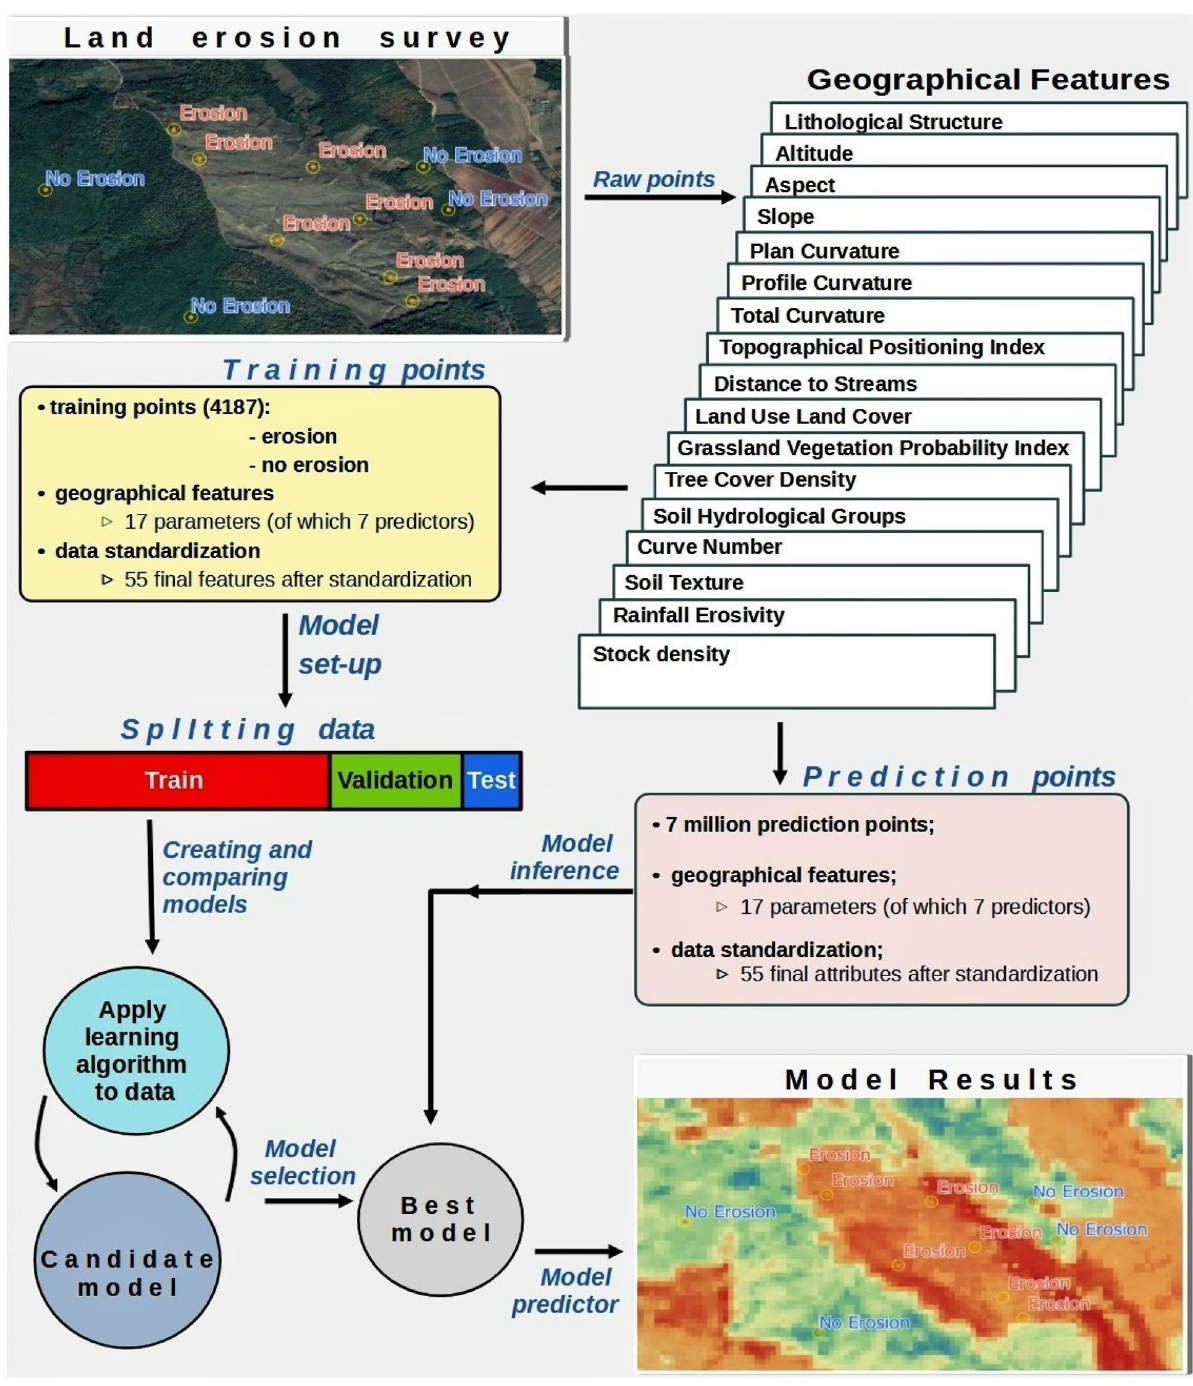
Figure 3. Workflow for designing Grazing Susceptibility to Land Degradation Index. The figure was designed by N. Ciobotaru in Microsoft 365 PowerPoint (https:// www. micro soft. com/ en- us/ micro soft- 365/ power To calculate the GSLDI, the ML models were trained to predict erosion exposure by using the 17 attributes and their classes as predictors, resulting in the probability of having erosion process on each pixel of the study area. The model set-up consists of randomly splitting the data (erosion and no-erosion points) into two catego- ries: training dataset (80%) and the test dataset. The test dataset was used to evaluate the model performance independently as it was not part of the training phase (Fig. 3). The validation set was drawn from the training dataset by means of tenfold cross-validation procedure. To evaluate and estimate the impact of SRs stock density over the land degradation process, we propose two SRs’ density scenarios: one considered 0 (absence), and another one with double density (overstocking).